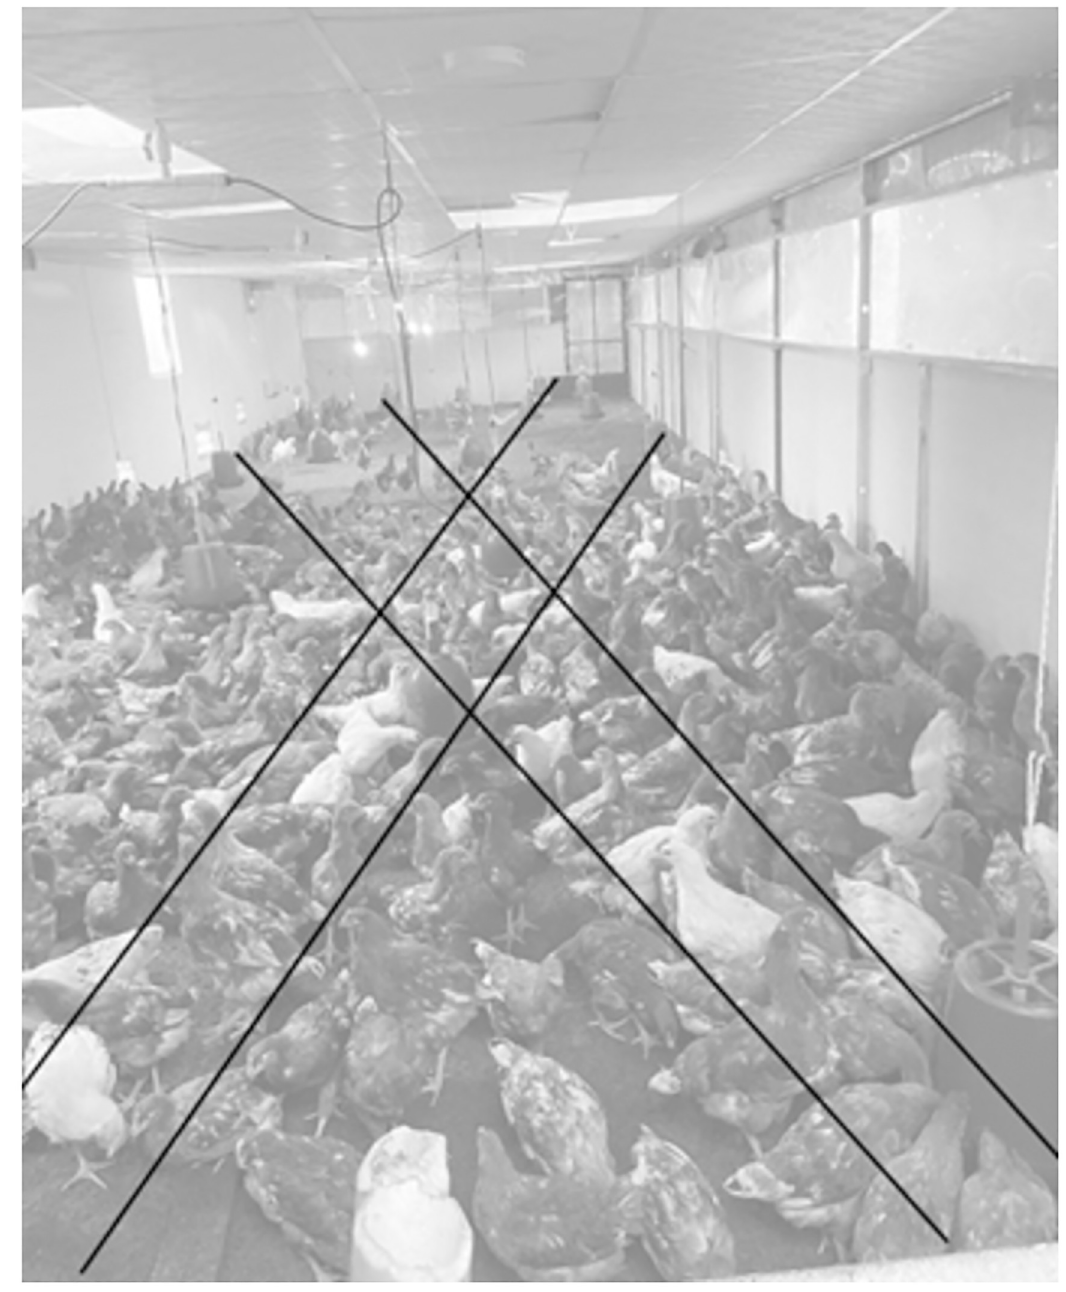
Fig 1. Sampling strategy of chicken in a farm- an imaginary diagonal lines from where birds were randomly selected and sampled.